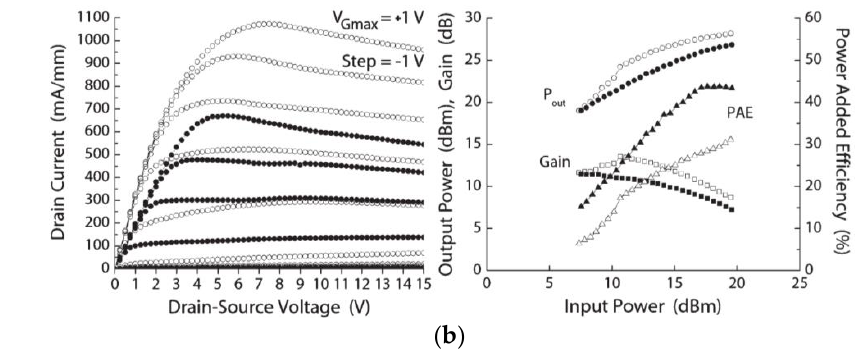
Figure 3. ( a ) SEM cross-section of a GaN-on-diamond wafer (© 2006 IEEE. Reprinted, with permission, from G. H. Jessen et al., “AlGaN/GaN HEMT on diamond technology demonstration,” Tech. Dig.— IEEE Compd. Semicond. Integr. Circuit Symp. CSIC, pp. 271–274, 2006 [63]). ( b ) Electrical characteristics of similar GaN-on-diamond (solid symbols) and GaN-on-SiC (open symbols) HEMTs; output power and PAE measured at 10 GHz CW class B operation and 20 V V D (© 2007 IEEE. Reprinted, with permission, from J. G. Felbinger et al., “Comparison of GaN HEMTs on diamond and SiC substrates,” IEEE Electron Device Lett. [65]).